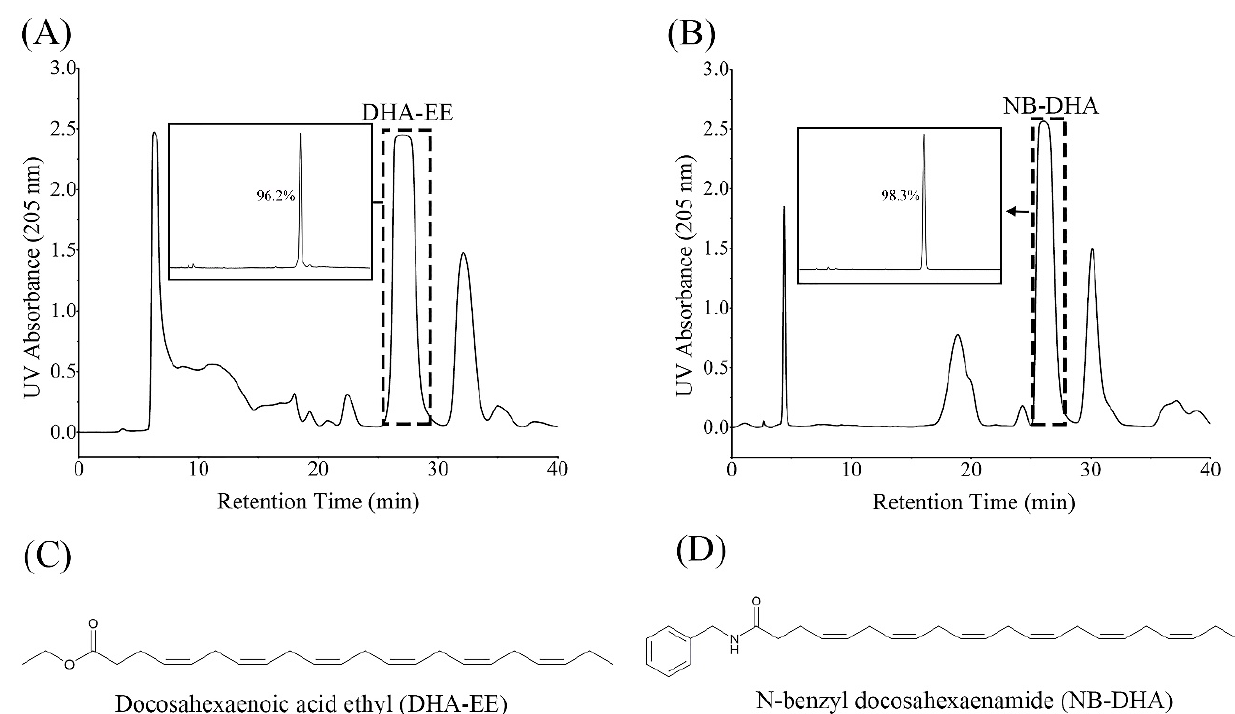
Figure 1. Chromatograms and structural formulas of DHA-EE and NB-DHA. ( A ) Chromatograms of synthetic DHA-EE material and purified DHA-EE sample collected using a semipreparative HPLC system (26.5–30.5 min). ( B ) Chromatograms of synthetic NB-DHA material and purified NB-DHA sample collected using a semipreparative HPLC system (26.0–29.0 min). Structural formulas of DHA-EE ( C ) and NB-DHA ( D ).